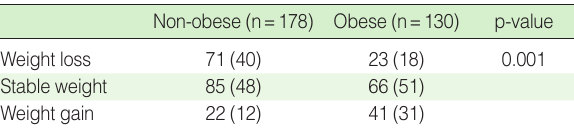
Table 3. Associations between post-morbid obesity status and weight change among patients with incident heart